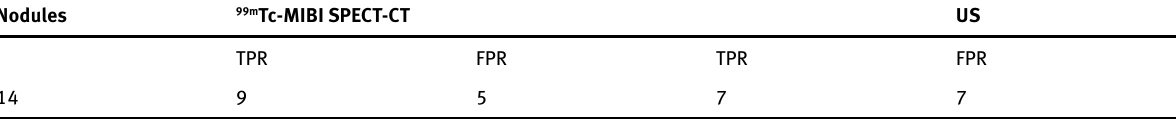
Table 2 Comparison of the number of parathyroid glands tested by US and 99mTc-MIBI SPECT-CT imaging Nodules